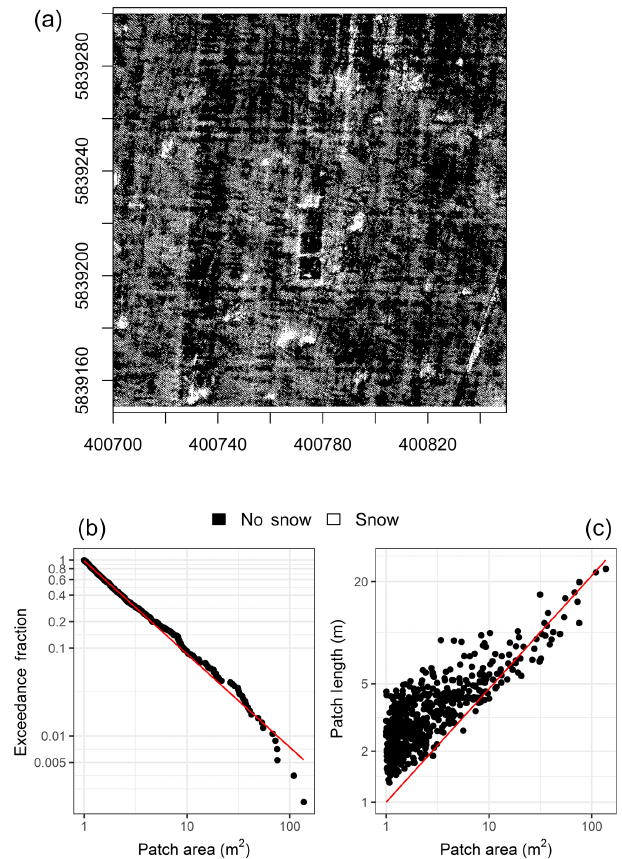
Figure 5. Example of snow-cover geometry scaling properties, ex- ceedance faction versus patch area ( b , D k = 21) and patch length versus patch area ( c , D (cid:48) = 122), for snow-covered area classifica- tion at 1m resolution from 29 March 2016 ( a , axes are UTM 13N northing and eastings). Red lines are the best-fit scaling relation- ships, where slope provides the scaling